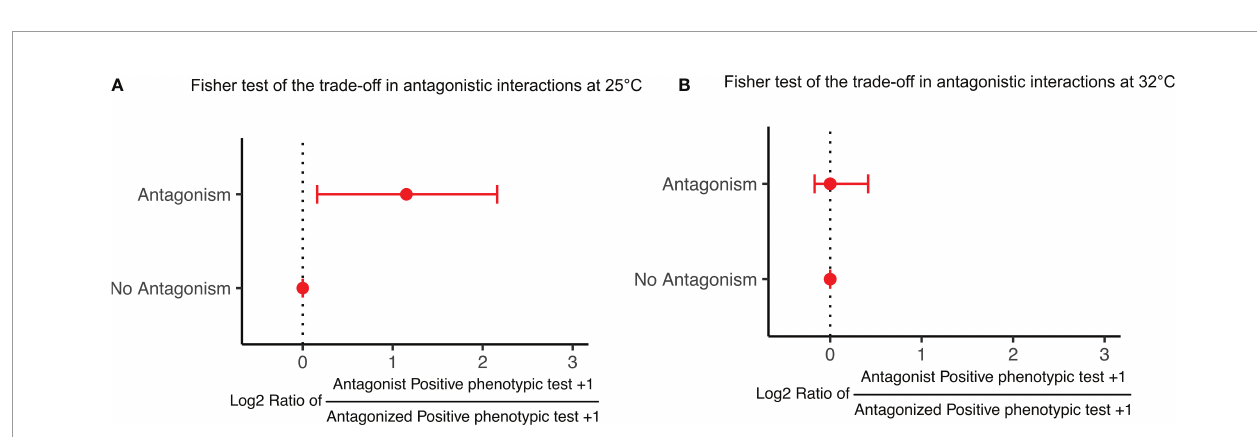
FIGURE 5 | Fisher test of the trade-off in antagonistic interactions at 25°C (A) and 32°C (B) . The log2 ratios between the number of carbon source utilized by the antagonists compared with the antagonized are larger than 0 when antagonism was observed ( P = 0.052, n = 44), but not different from 0 for the non-antagonistic interactions ( P = 0.999, n = 948) at 25°C (A) ; however, no differences from 0 for all interactions at 32°C (B) (antagonism: P = 0.881, n = 57; no antagonism: P = 0.981, n = 935). One autoinhibition pair was removed. P values are one-tailed tests of whether medians are larger than 0 estimated from 1,000 bootstrap realizations. Points are medians, and error bars are 90% bootstrapped con fi dence limits of the medians (equivalent to a 5% one-tailed test of the